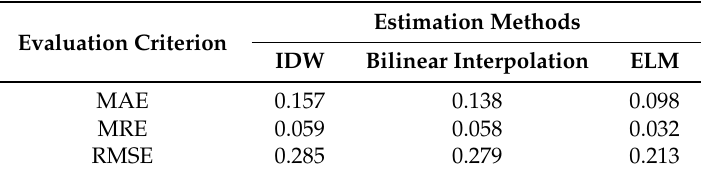
Table 2. Performance of the estimation methods in test Region 1. MRE, mean radial error; IDW, inverse distance weighted method.